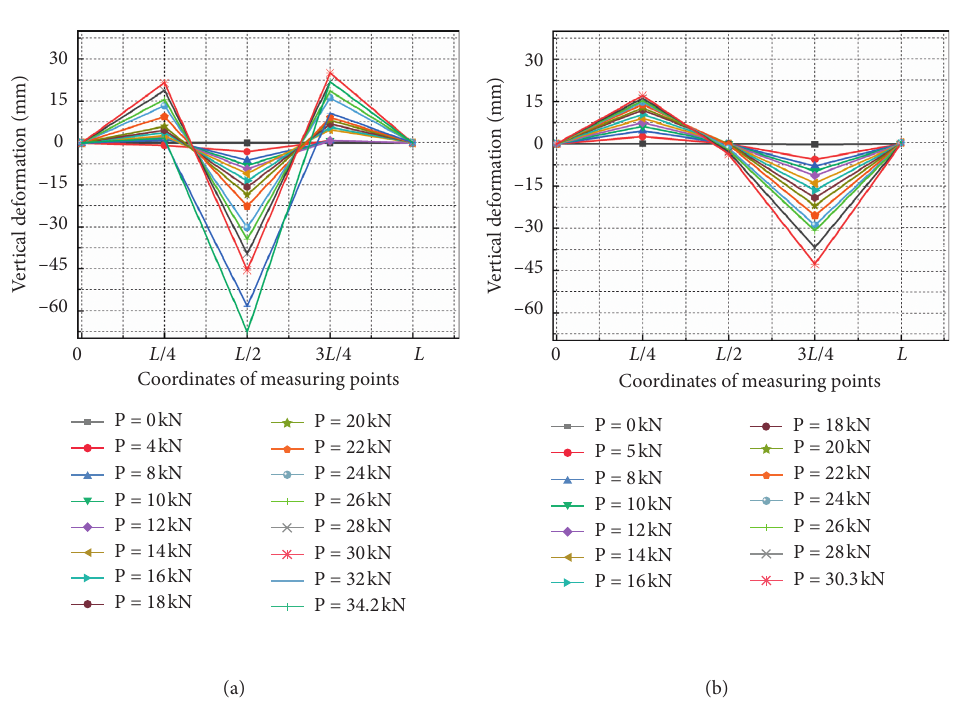
Figure 6: Experimental vertical displacement distributions: (a) under mid-point and (b) quarter-point loads.